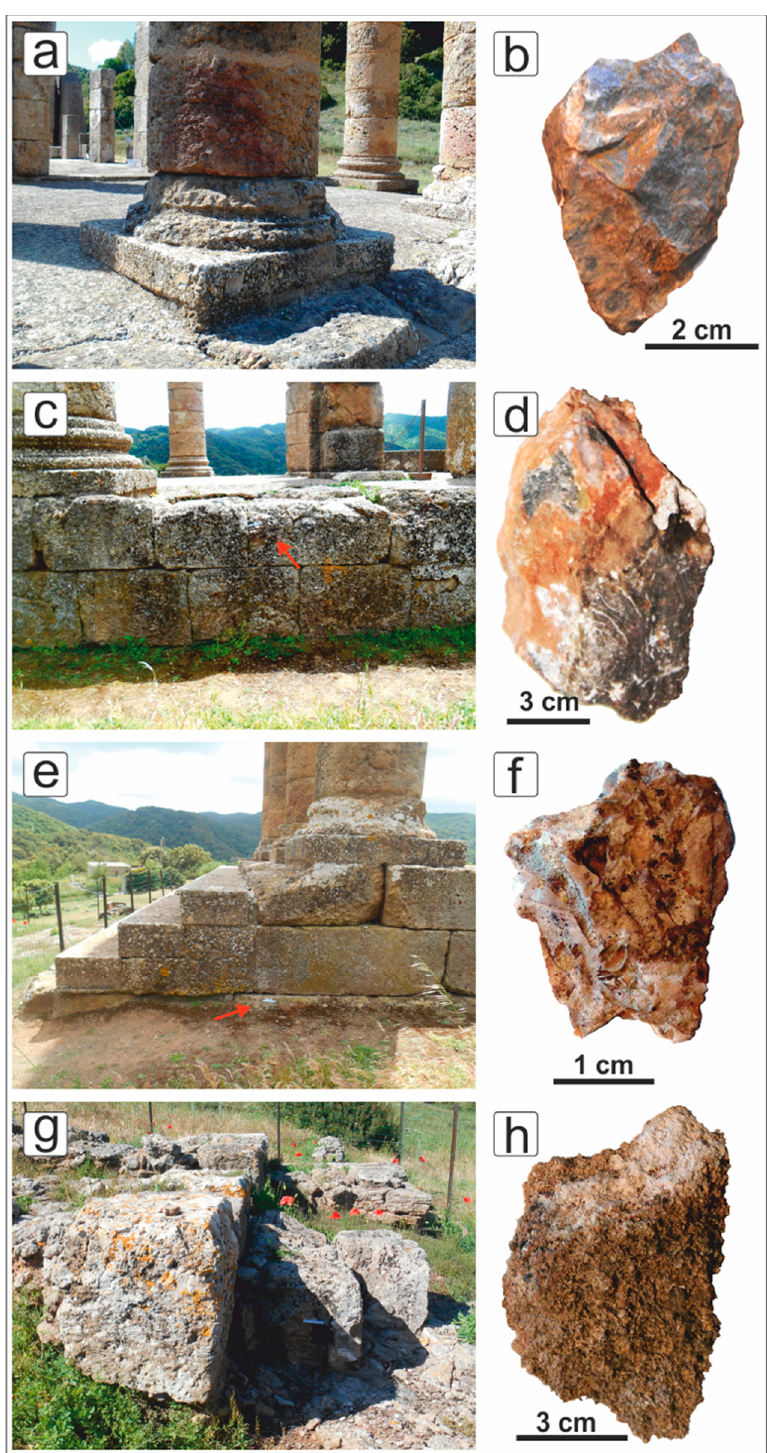
Figure 8. ( a , b ) massive metadolostone sampled in the Roman temple (sample TAR22); ( c , d ) laminated metadolostone sampled in the Roman temple (sample TAR3); ( e , f ) brecciated metadolostone collected at the base of Roman temple (sample TAR1); ( g , h ) fossiliferous sandstone (samples TAP23, 27, 31) from the Punic temple. Note: the red arrows indicate the sampling points.